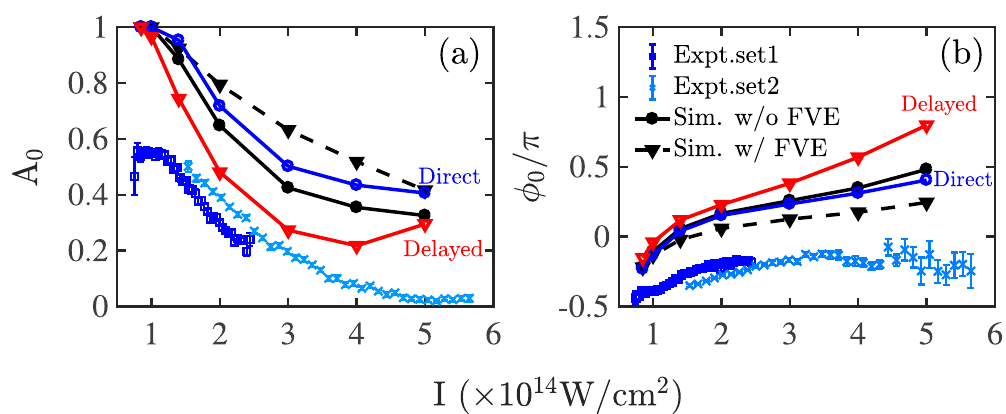
Figure 9. Asymmetry parameters A 0 ( a ) and φ 0 ( b ) as a function of intensity. The computed results for all doubly-ionized events when the focal volume effect is not accounted for are denoted by black solid lines with circles and when it is accounted for by black dashed lines with triangles. The delayed pathway of double ionization is denoted by red solid lines with triangles and the direct pathway by blue solid lines with circles. For the direct and delayed pathways of double ionization the focal volume effect is not accounted for. Experimental results 8 are denoted by light blue crosses and dark blue